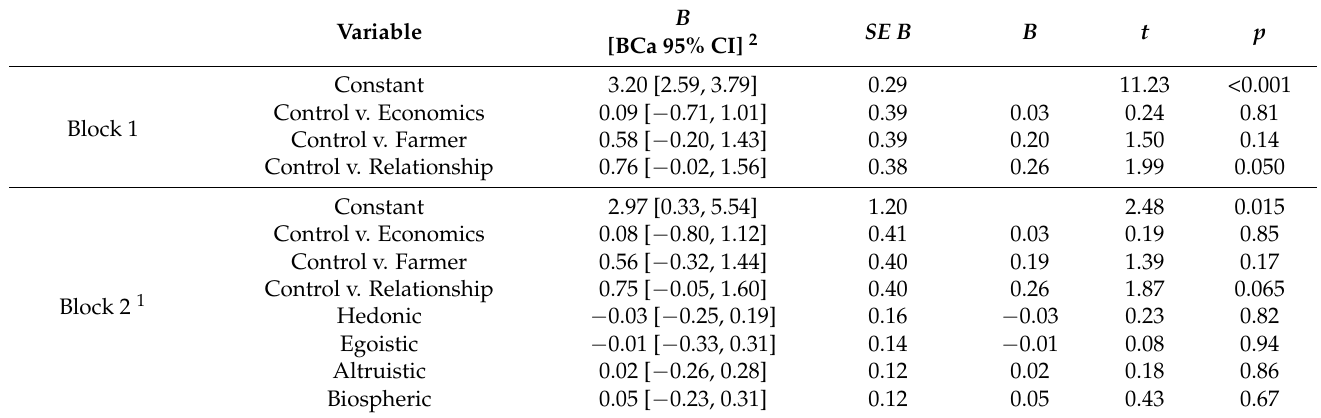
Table 7. Hierarchical Regression Model for Values as Predictors of